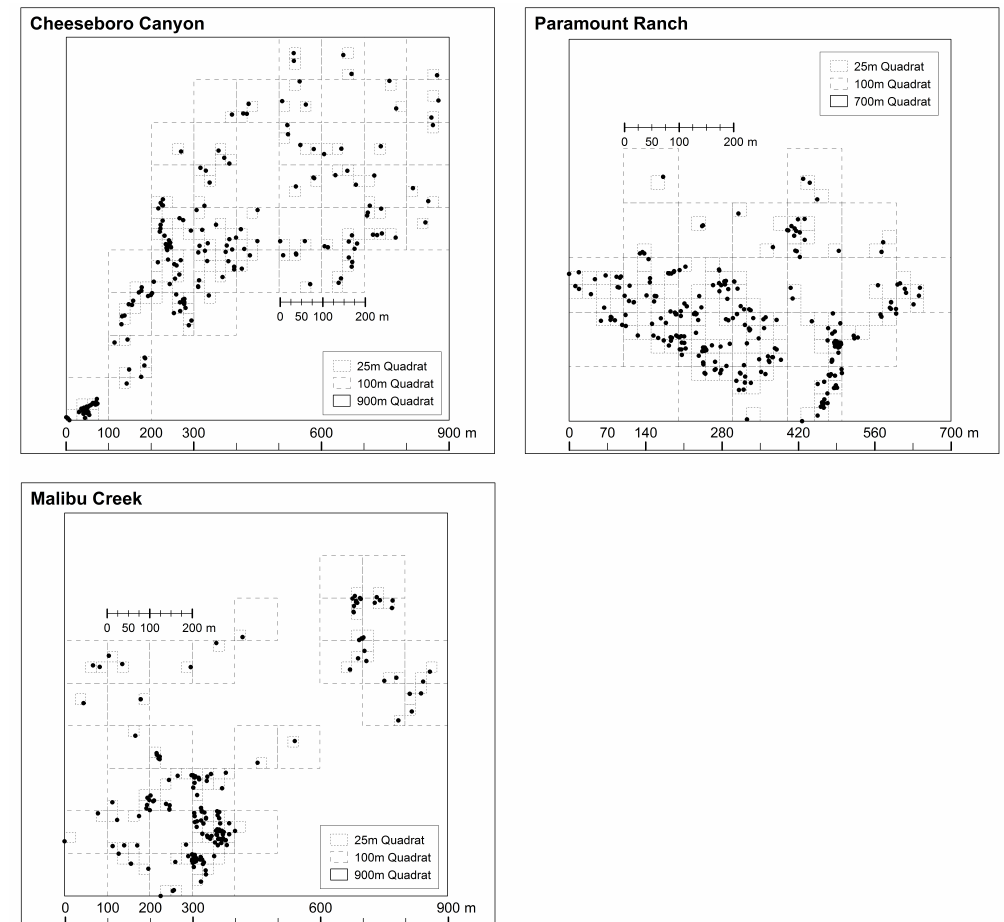
Figure 2. Different quadrat sizes: (25 m, 100 m, and the maximum extent), for the three populations result in different observations of “clumps” or groups of